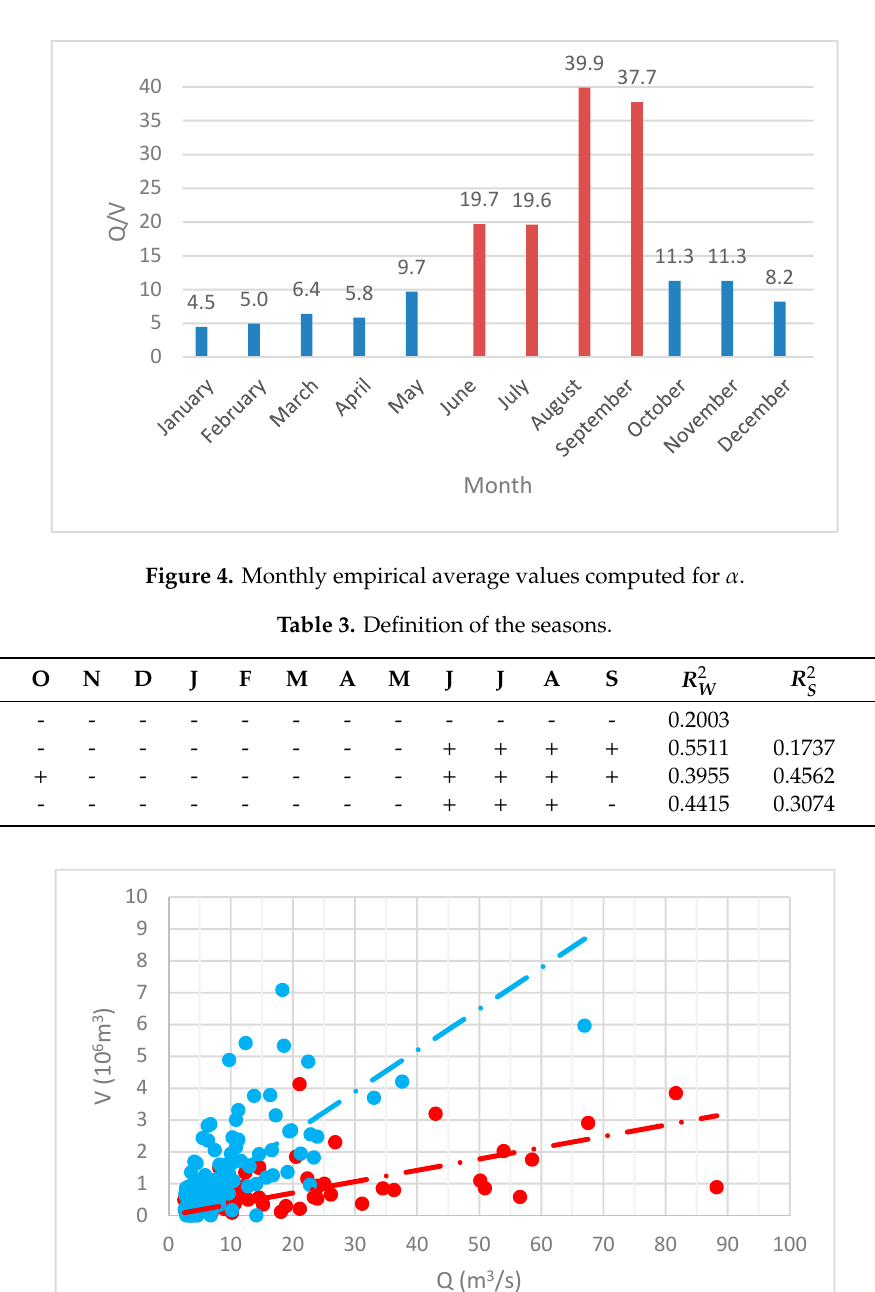
Table 4. Basic empirical statistics of Q, V for the different samples considered.